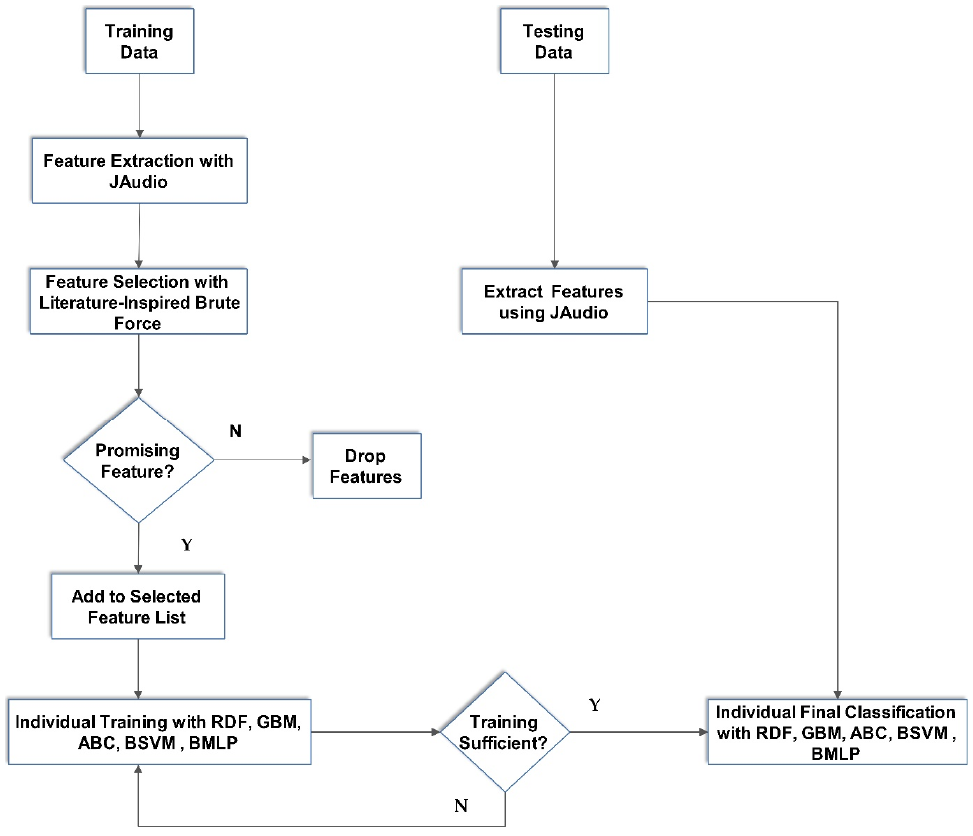
Figure 3. Flowchart for different configurations of emotion recognition methods .